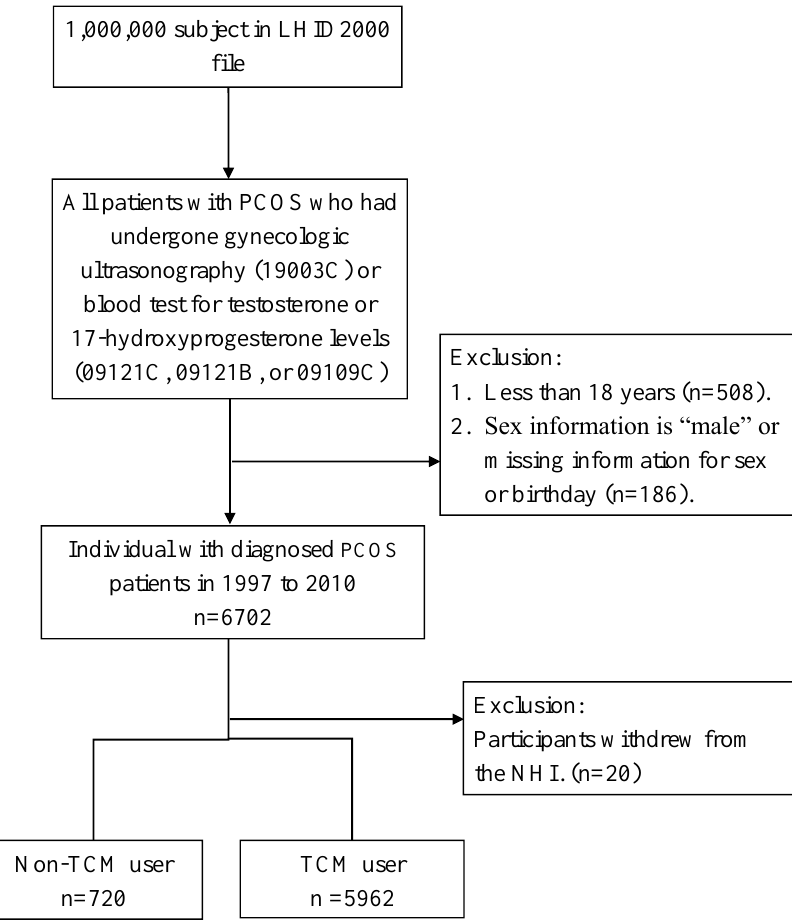
Figure 1. Flowchart of subjects from the one million samples randomly selected from the National Health Insurance Research Database (NHIRD). TCM: traditional Chinese medicine; PCOS: polycystic ovary syndrome; NHI: National Health Insurance.